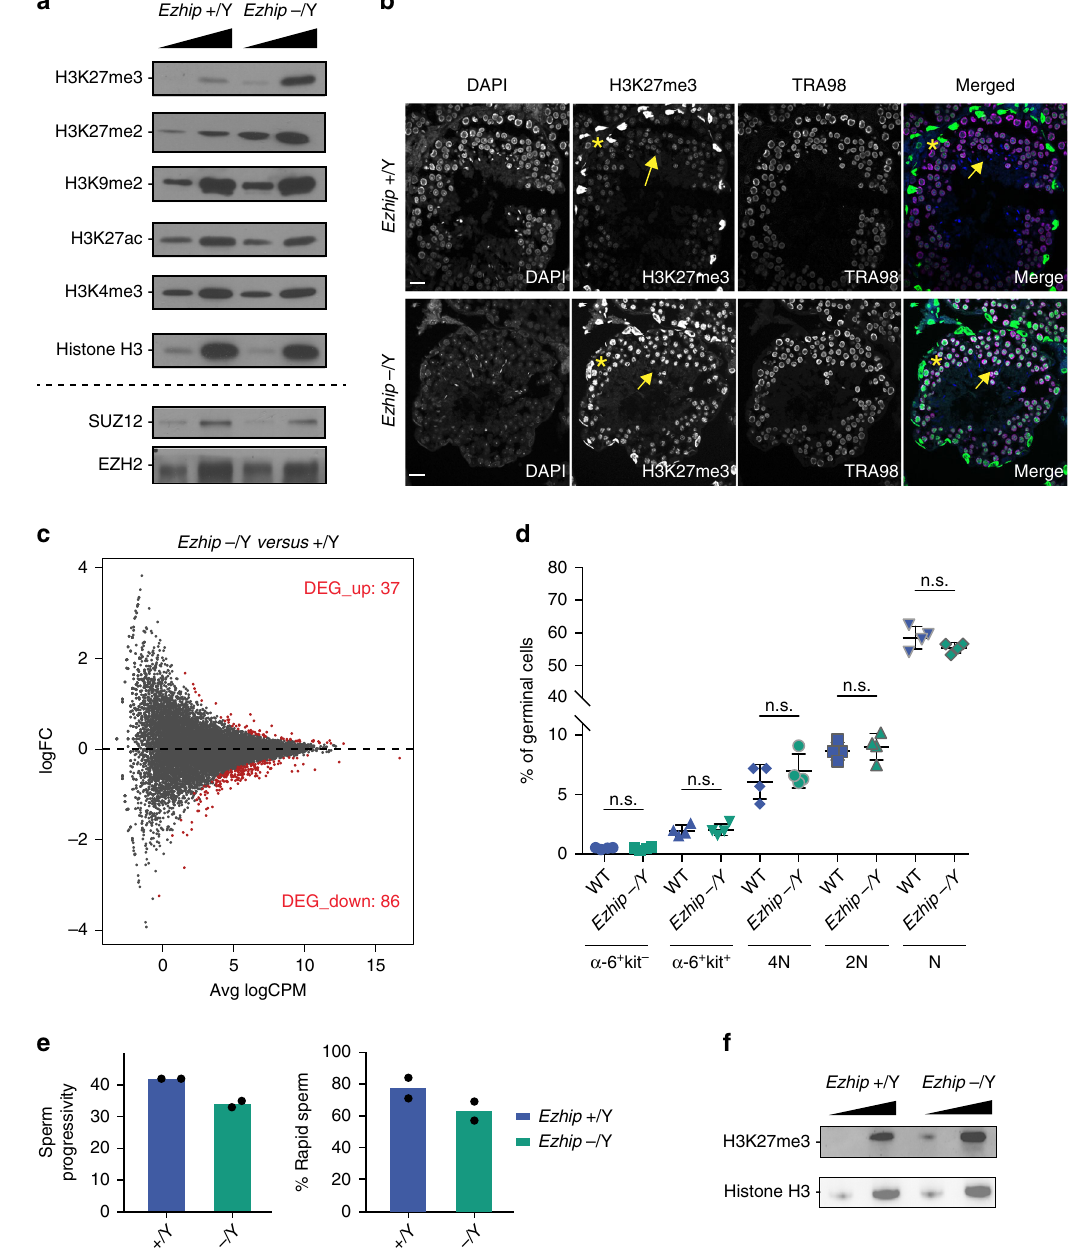
Fig. 5 Global increase of H3K27me2/3 in male germ cells Ezhip − / − . a Western blot analysis of H3K27ac, H3K4me3, H3K27me3, H3K27me3, H3K9me2, and H3 on whole testis extracts WT and Ezhip − /Y (titration 1, 2.5×). Bottom, same extracts probed for EZH2 and SUZ12. b Immuno fl uorescence detection of H3K27me3 (green) and TRA98 (purple) in testis sections (6-month-old mice). The nucleus is stained with DAPI. Representative results, n ≥ 2. Scale bar, 25um. c Mean-difference plot between adult male WT and Ezhip − /Y sorted spermatogonial population. Differentially expressed genes are highlighted in red (upregulated: 37; downregulated: 86, FDR<0.05), n = 2. d Quanti fi cation of spermatocyte I (4N), spermatocyte II (2N), spermatids (N), and differentiating (a-6 + kit + ), and undifferentiated spermatogonial (a-6 + kit-) by FACS in percent of the total germinal cell population from WT and Ezhip − /Y mice (mean± sem, n = 4, Signi fi cance: unpaired, non-parametric test of Kologorov – Smirnov). e Sperm quality was measured using computer-assisted IVO technologies comparing WT and Ezhip − /Y knockout males. Lower left panel: percent sperm progressivity. Lower right panel: percent sperm rapidity (mean, n = 2). f Western blot analysis of H3K27me3 and H3 on mice sperm extracted from WT and Ezhip − /Y